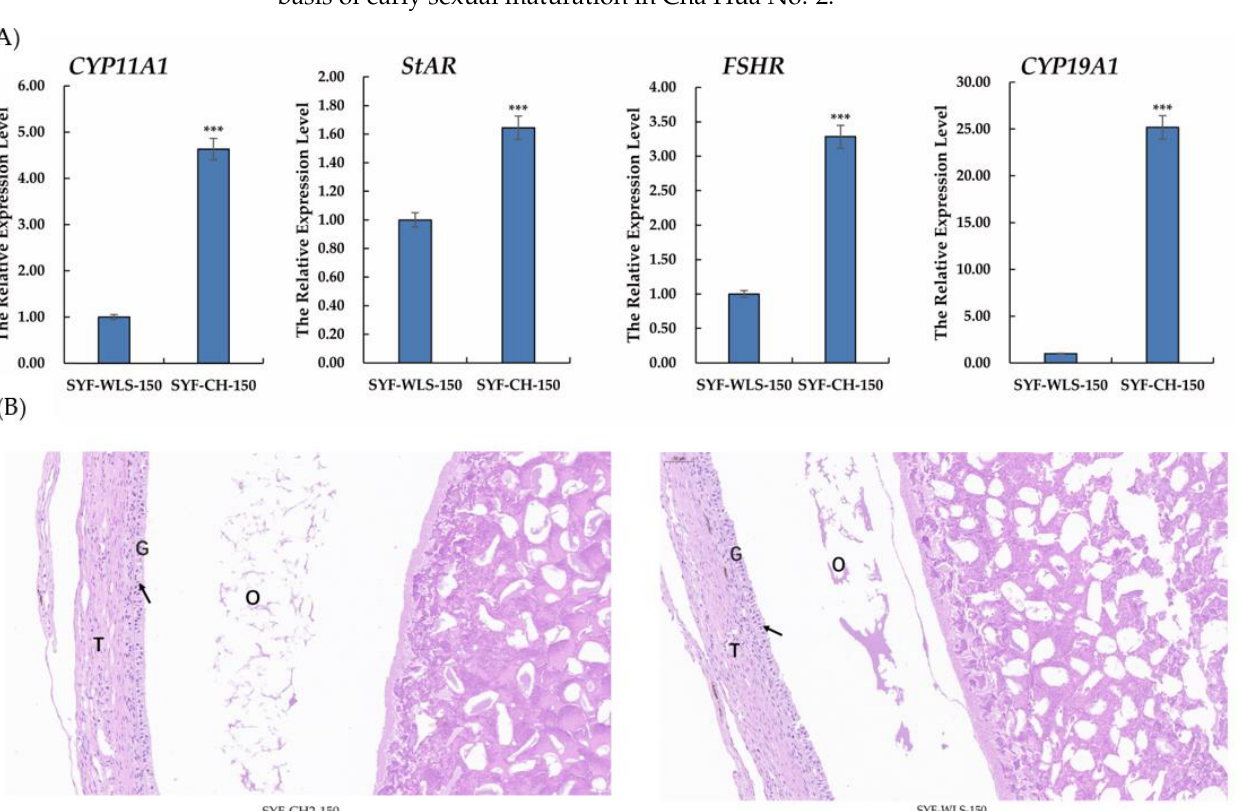
Figure 2. ( A ) Relative mRNA expression levels of genes associated with sexual maturation in SYF tissue. SYF-WLS-150 represents small yellow follicles of Wu Liang Shan at the age of 150 days. SYF-CH-150 represents small yellow follicles of Cha Hua No. 2. at the age of 150 days. *** p <0.001 ( B ) The results of H&E staining, showing the three main parts of SYF. T: thecal cell layer; G: granulosa cell layer; O: oocytes. The figures were imaged at 20× magnification. Arrows point to the granulosa cell layer.